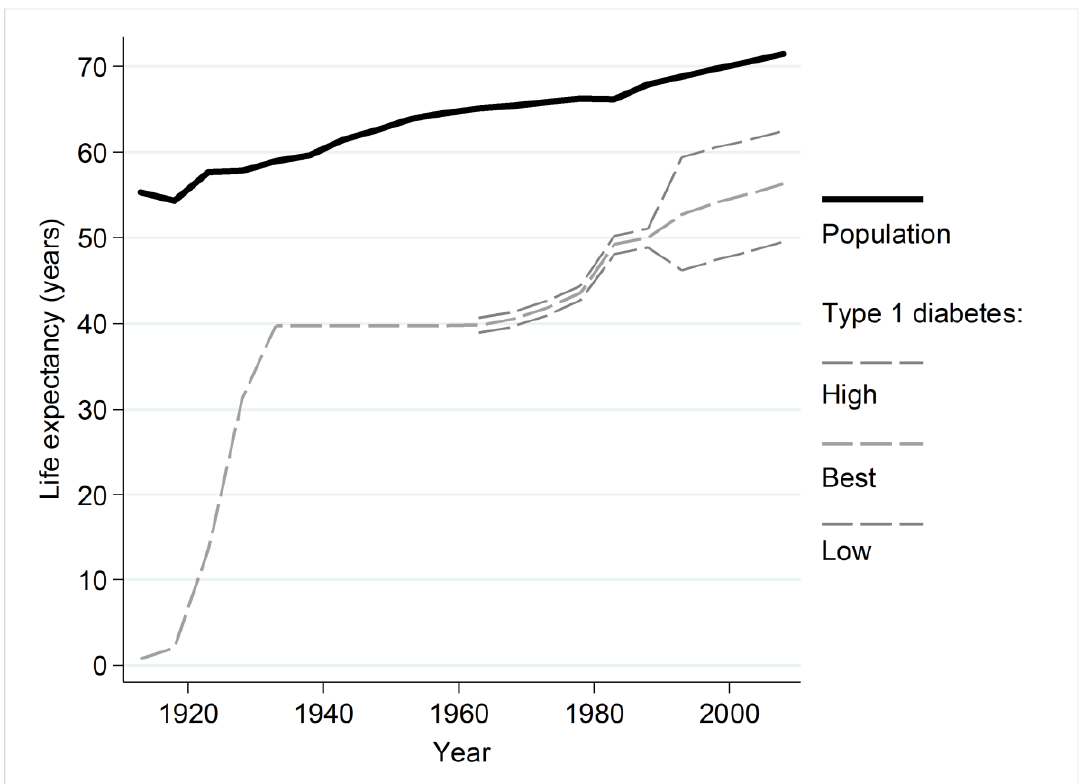
Figure 1: Life expectancy for a patient who developed type 1 diabetes at the age of 10 years during 1910-2010. Source Steen Carlsson et al.,